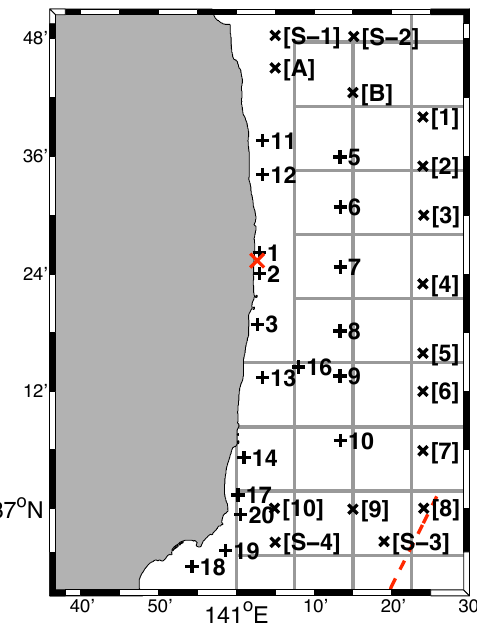
Fig. 2. Map of 137 Cs observations and model grid. The black crosses indicate measurements by TEPCO, the black x those by MEXT and the red x marks the nuclear power plant. The grey squares indicate “wet” model grid-boxes. In Fig. 7 and Fig. 8 the observations are binned into their nearest “wet” model grid-box neighbor. The TEPCO positions carry a reading error because they are copied from a map. The red dashed line in the lower right corner is the 200m